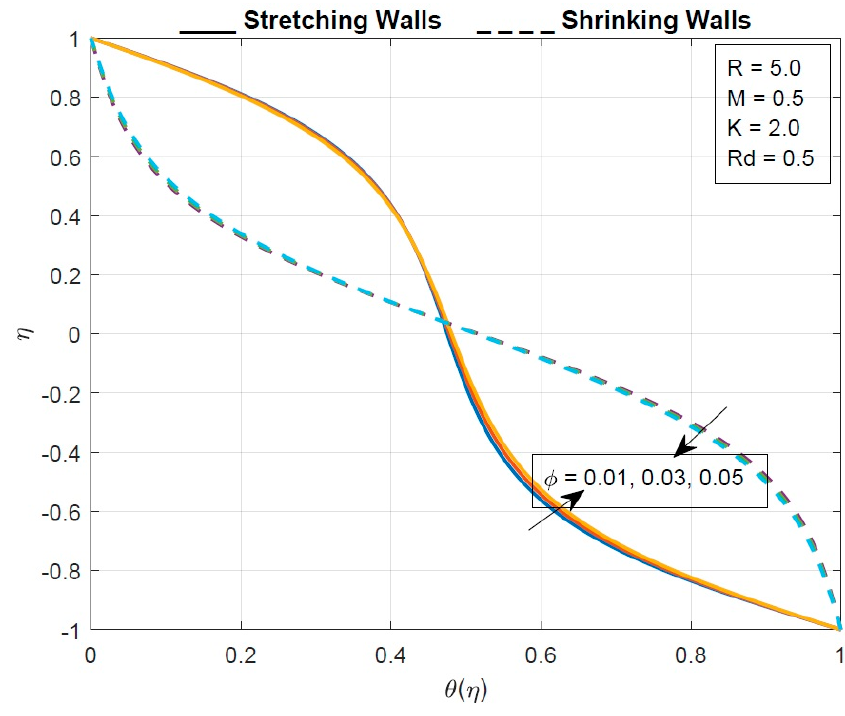
Figure 8. The effect of the solid volume fraction on the temperature profile.